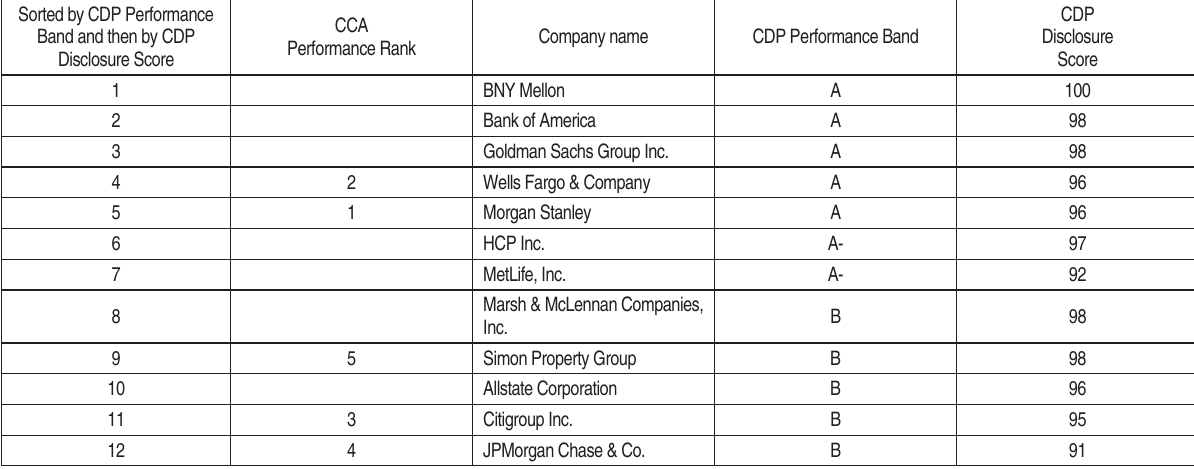
Table 4. Climate Change Action (CCA) Performance Ranking Versus Ranking by CDP Performance Band & CDP Disclosure Score 2013 Sorted by CDP Performance Band and then by CDP Disclosure